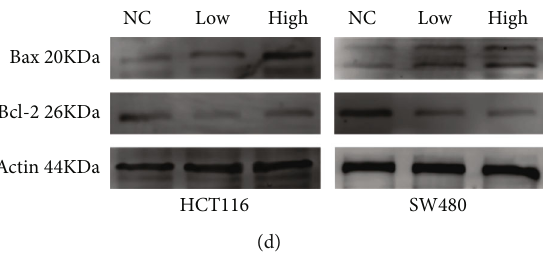
Figure 3: Feno fi brate treatment promoted colon cancer cell apoptosis. (a) Cell apoptosis was analyzed using fl ow cytometry. (b) TUNEL staining of colon cancer cells was observed after treatment of feno fi brate for 24h. TUNEL-stained (green) cells indicate apoptosis-positive cells, DAPI (blue) indicates nucleated cells, and the merge column shows cells stained with TUNEL and DAPI. (c) Morphological changes were observed of HCT116 and SW480 cells after treatment of feno fi brate for 24h. (d) The protein expression of Bax and Bcl-2 in SW480 and HCT116 cells was measured using western